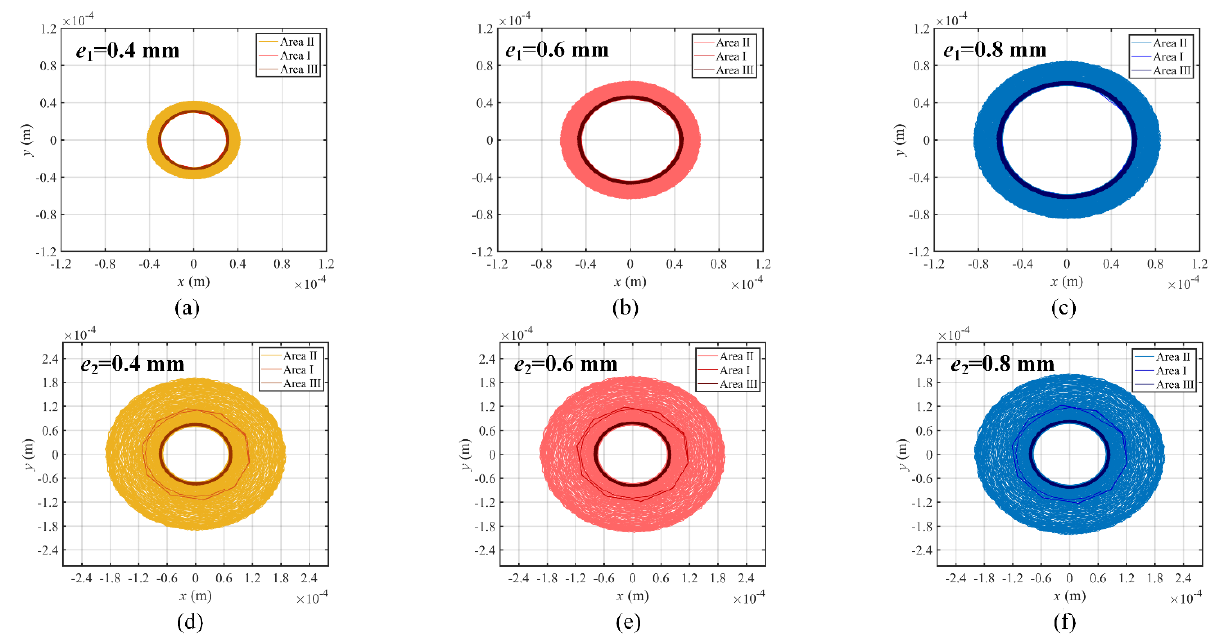
Figure 15. The axis trajectory of the generator rotor and the hydro-turbine runner under different mass eccentricities. ( a – c ) Generator rotor; ( d – f ) hydro-turbine runner.